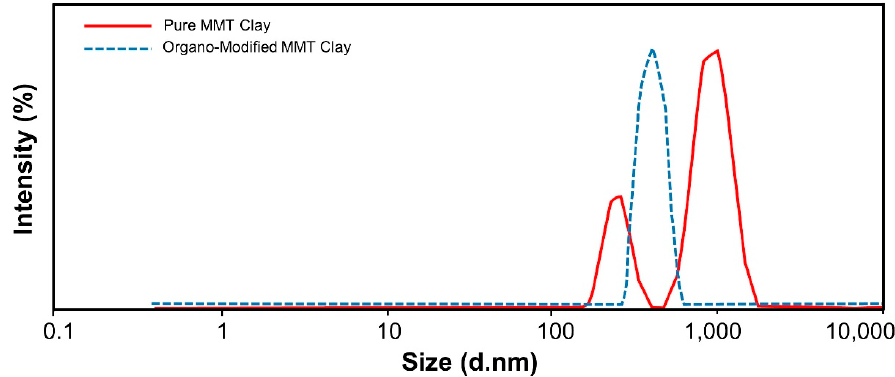
Figure 3. Particle size analysis of pure montmorillonite clay and organo modified MMT clay. Table 1. Particle size analysis of untreated and organo modified MMT clay.